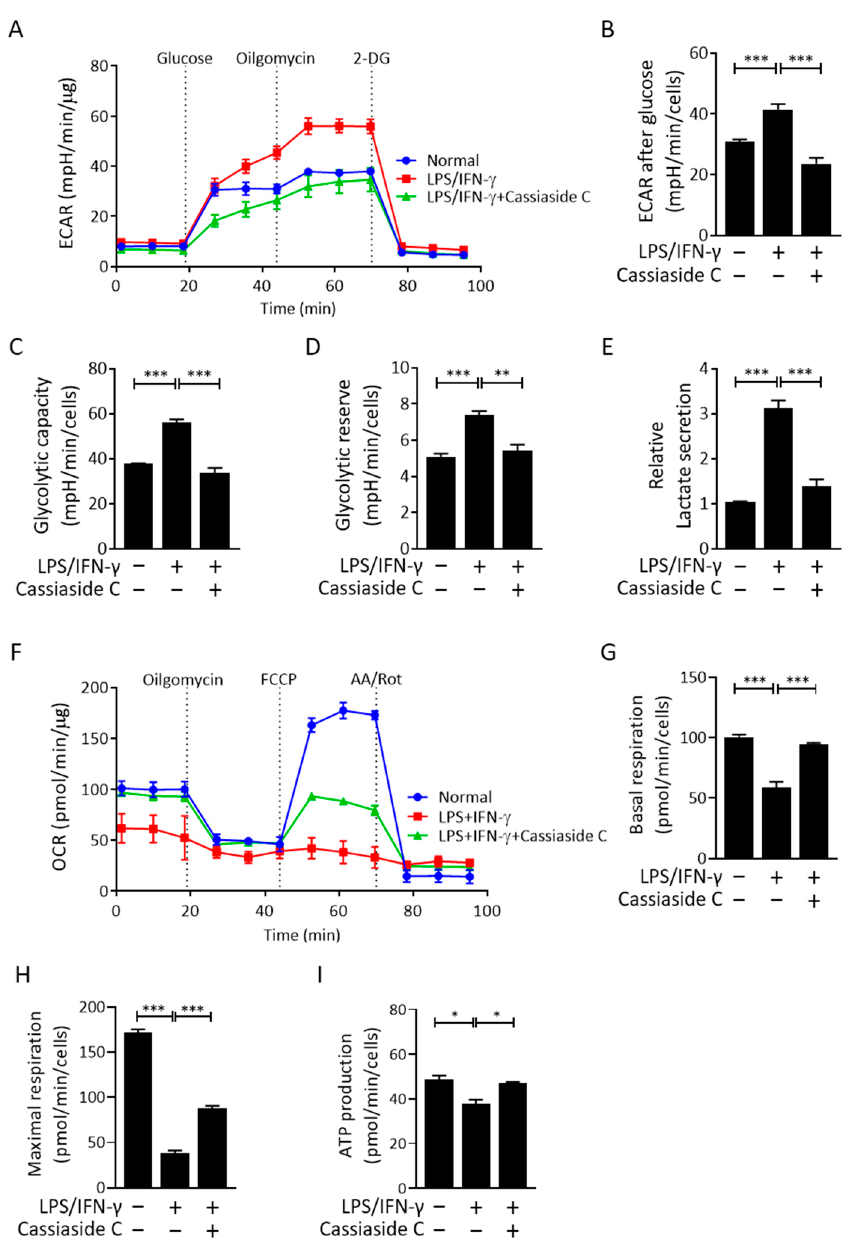
Figure 4. Cassiaside C suppresses glycolysis but increases mitochondrial respiration in LPS/IFN- γ - stimulated macrophages. ( A – E ) The ECAR in LPS/IFN- γ -stimulated macrophages. ECAR kinetic traces ( A , B ), glycolytic capacity and reserve ( C , D ), and lactate levels ( E ) in LPS/IFN- γ -stimulated macrophages treated with or without Cassiaside C. ( F – I ) OCR kinetic traces ( F ) and rates of basal ( G ), maximal ( H ), and ATP-linked ( I ) respiration in LPS/IFN- γ -stimulated macrophages treated with or without Cassiaside C. Data are expressed as the mean ± SEM ( n = 3 technical replicates). * p < 0.05, ** p < 0.01, and *** p < 0.001. 2-DG, 2-deoxyglucose 2-Dexyo glucose. AA, antimycin A/Rot,